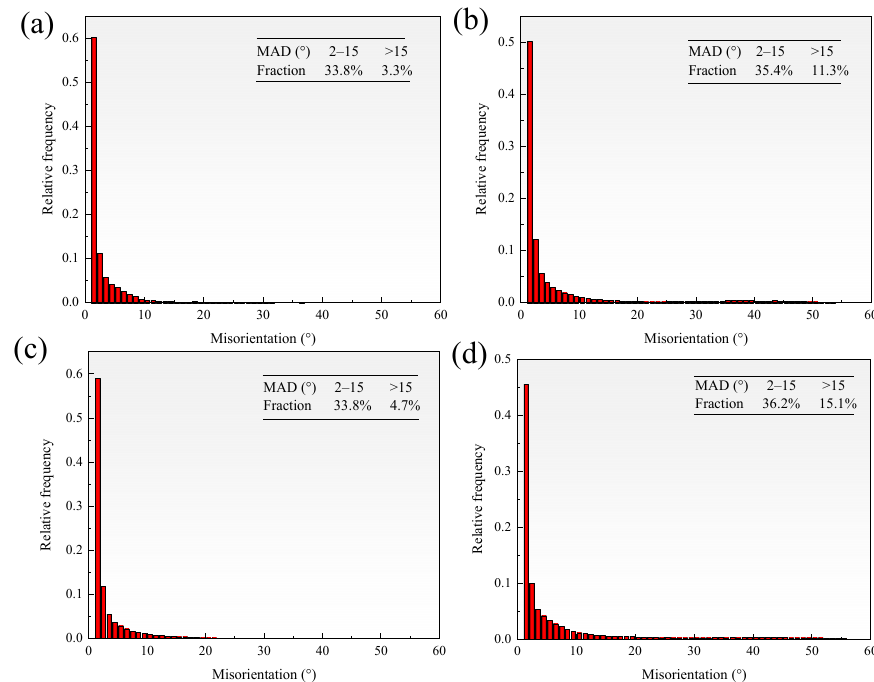
Figure 7. Misorientation angle distribution (MAD) histogram of 1561 aluminum hot rolled plate. ( a ) the H1 plate; ( b ) the H2 plate; ( c ) the N1 plate; ( d ) the N2 plate. The accumulated deformation of the material influences the grain orientation and micro texture, which significantly affect the mechanical properties of the hot rolled